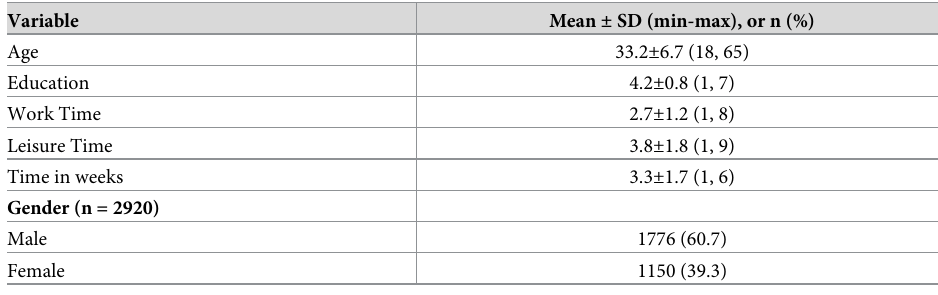
Table 1. Characteristics of study participants (n =